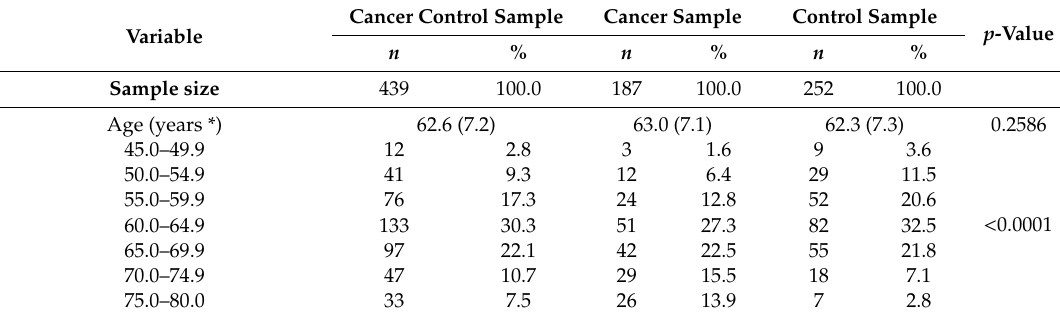
Table 1. Characteristics of the lung cancer sample and control